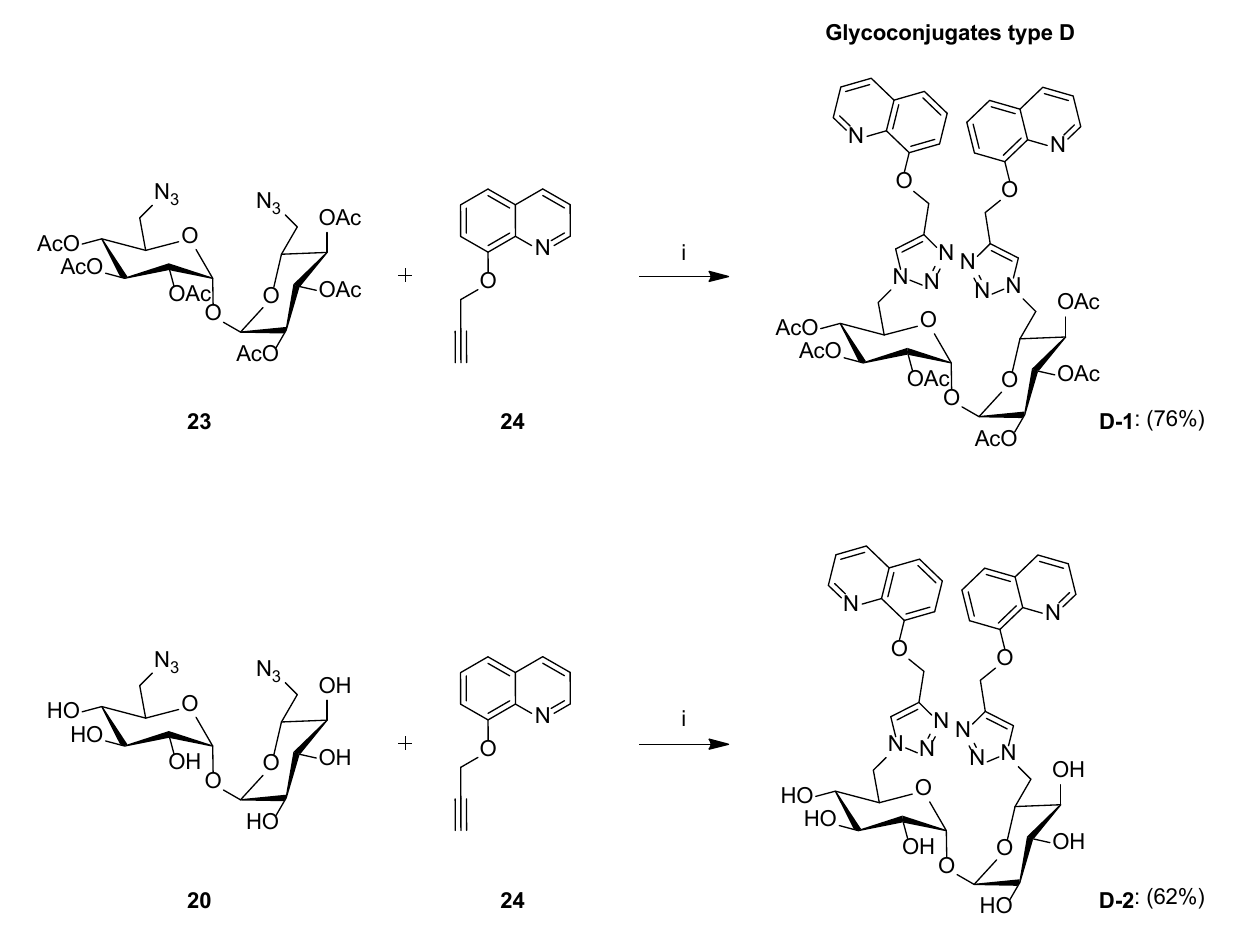
Scheme 8. Synthesis of type D glycoconjugates. Reagents and Conditions: ( i ) CuSO 4 ·5H 2 O,